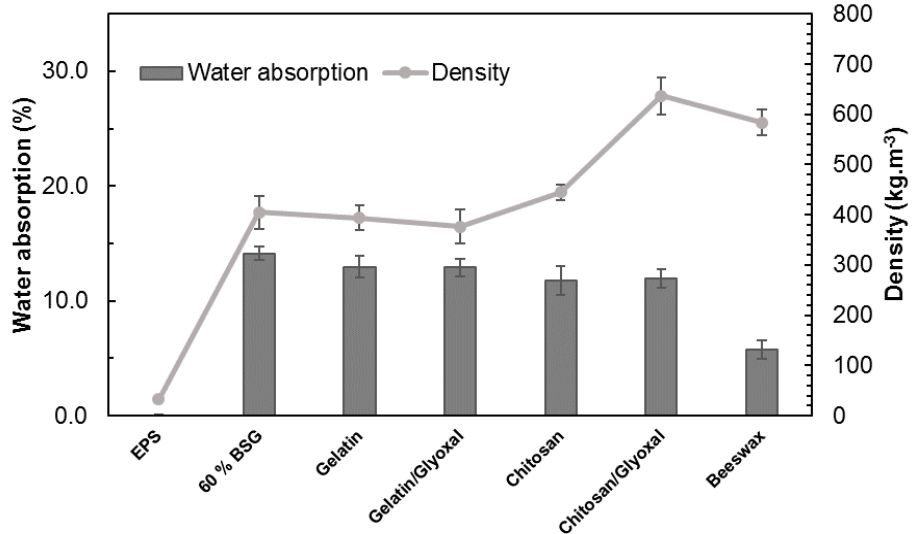
Figure 9. Weight variation of EPS samples and the trays with 60% of BSG and different additives (gelatin, gelatin and glyoxal, chitosan, chitosan and glyoxal and beeswax) after being exposed to a cotton strip (25 mm × 15 mm) with 90 wt % of moisture for 24 h. The respective densities are presented.